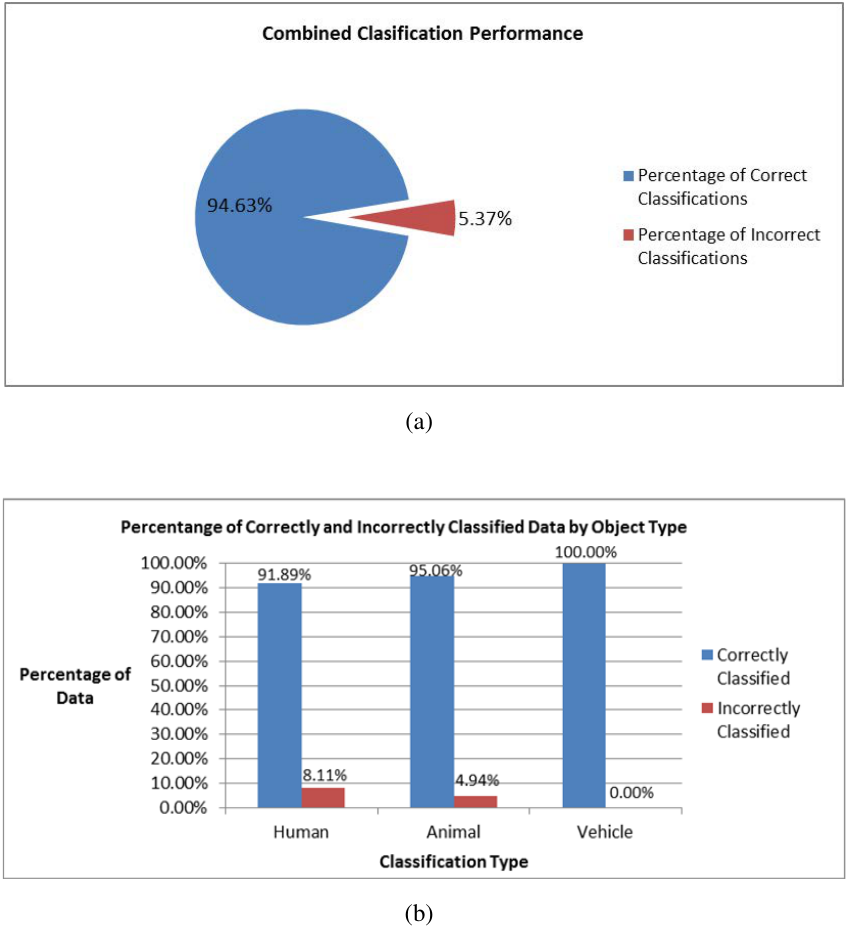
Figure 16. Classification results ( a ) Overall combined percent of correct and incorrect classification results, ( b ) Correct and incorrect classification results by object classes.